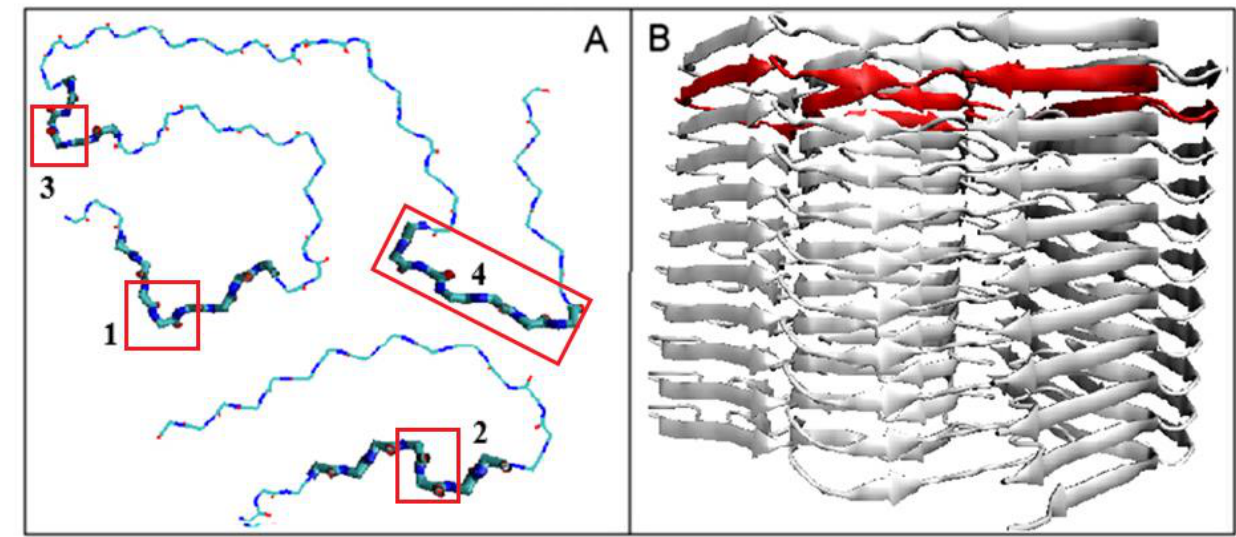
Figure 4. The structure of transthyretin chain in amyloid fibril. ( A ) — single chain (6SDZ) — sections maintaining a flat chain arrangement with specific non- β -structural conformations are highlighted (see their classification in Table 1). ( B ) — amyloid fibril with one chain marked in red for better visualization. The distinguished red chain in ( B ) is shown in ( A ) section in another perspective. The aim of both presentations is to show the planarity of the chain structure.